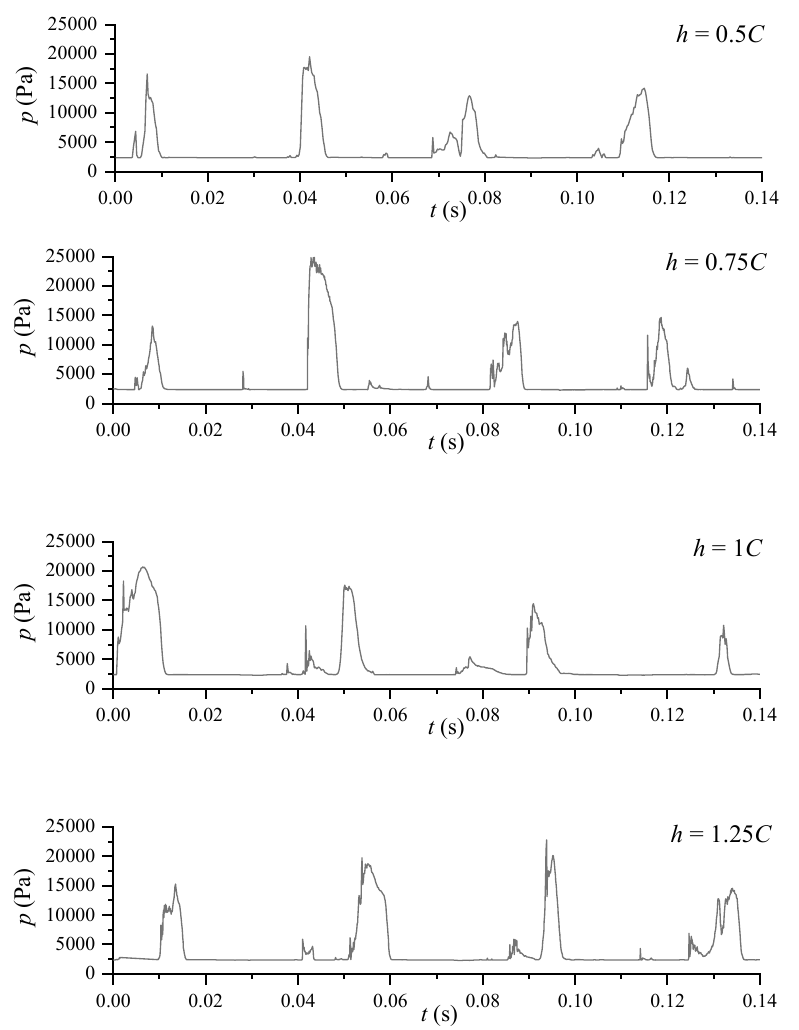
Figure 16. Comparison of the pressure fluctuation on the suction surface of hydrofoil at P3 in di ff erent water depth condition.